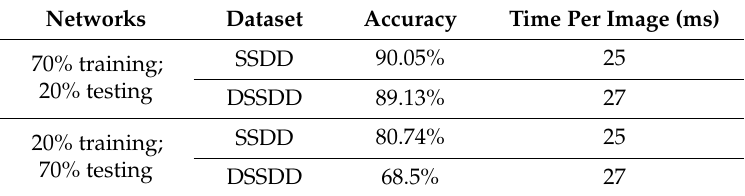
Table 5. The performance of YOLOv2 architecture with various training and testing data compositions.